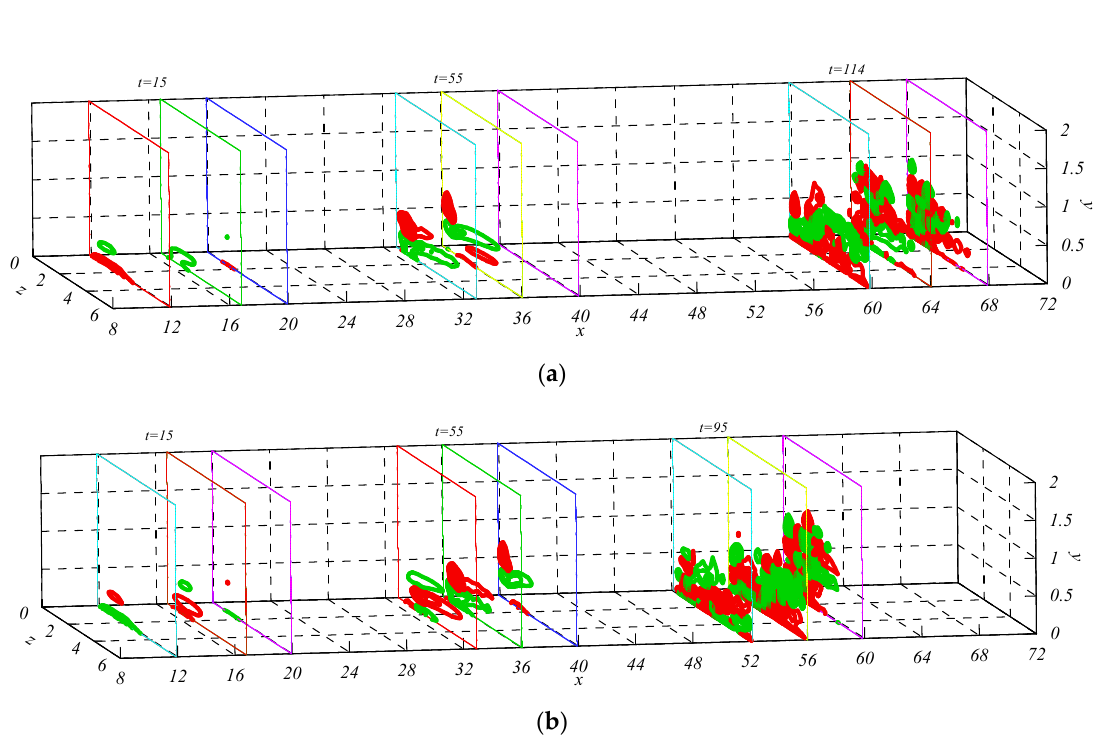
Figure 7. Stream-wise vortices: ( a ) P–N model; ( b ) N–P model.